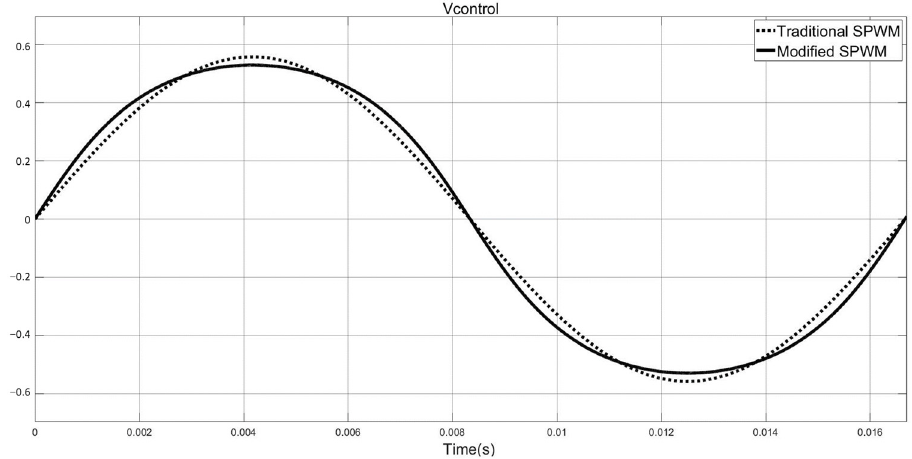
Figure 13. Comparison of V control between the traditional SPWM and modified SPWM controls.